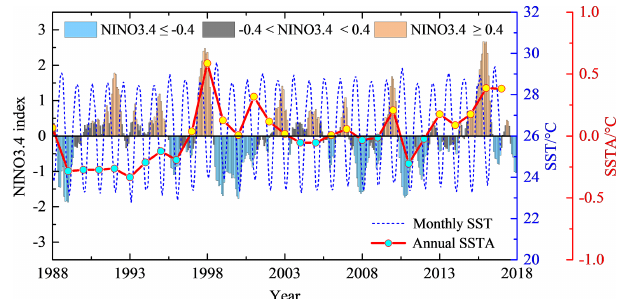
Figure 5. The NINO3.4 index and SST/SSTA during 1988 to 2017. (El Niño is in pink and La Niña is in